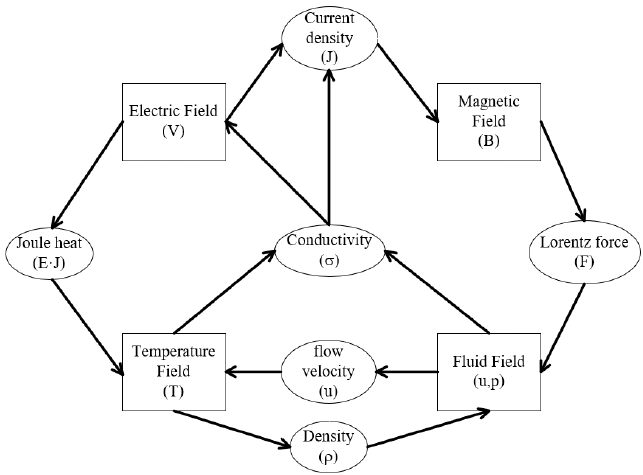
Figure 2. Arc discharge multi-physics field coupling